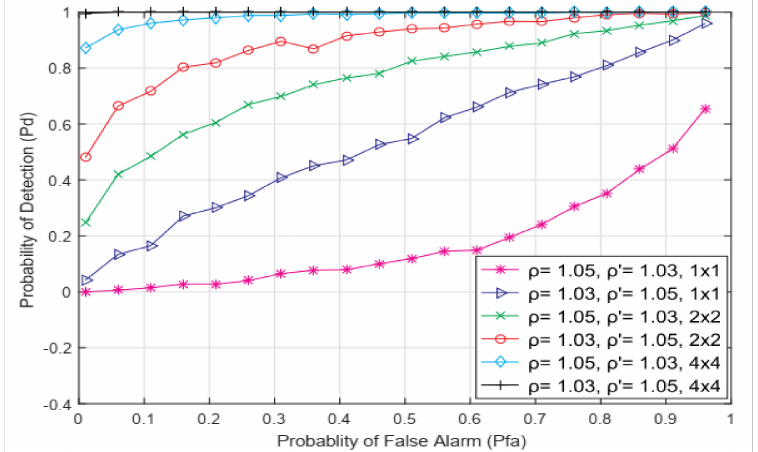
Figure 8. The ROC curves for various NU and DDT factor combinations in SISO and symmetric MIMO systems for transmission characterized with QPSK modulation, N = 128, SNR = − 15 dB and P Tx = 100 mW.